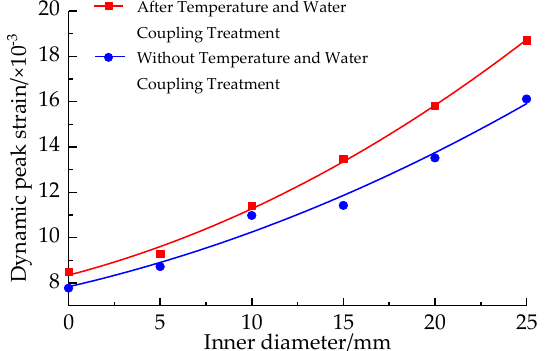
Figure 10. Diagram of the dynamic peak strain and annular diameter change.